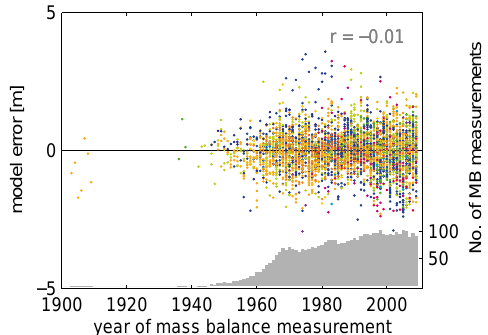
Fig. 11. Cross-validation results; errors of the modeled mass bal- ances as a function of time, and number of observed mass balances as a function of time; the number in the upper right indicates cor- relation (not significant above 95% confidence interval); gray bars indicate the number of MB measurements per year (right